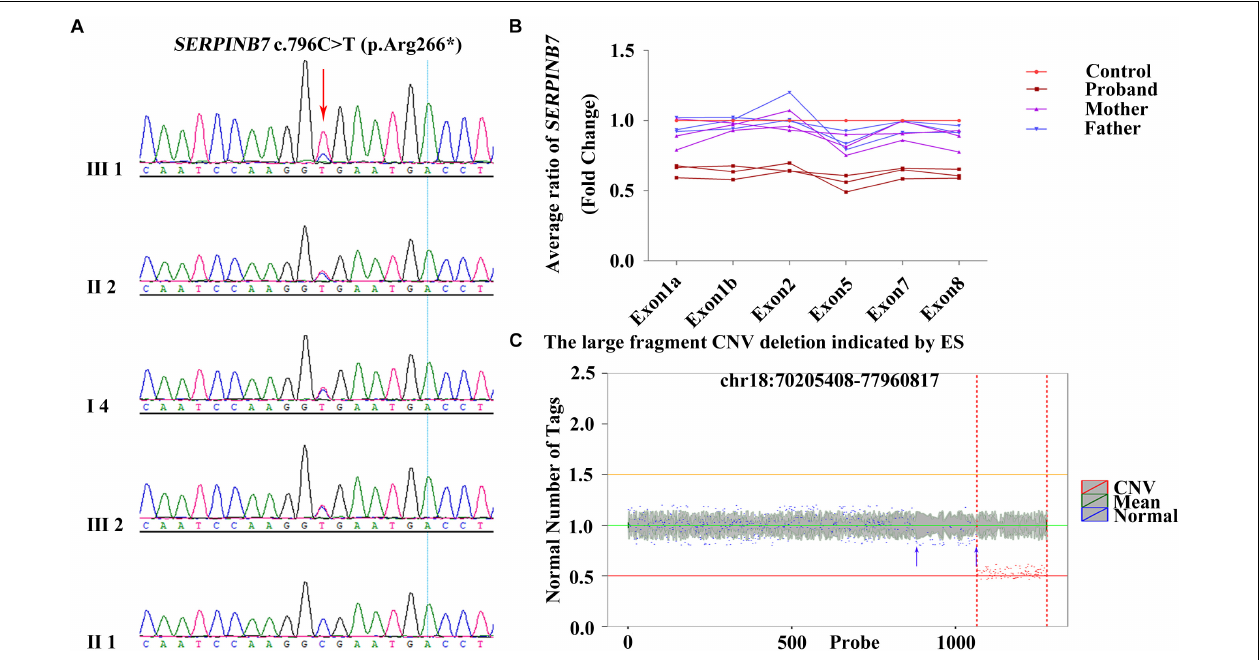
FIGURE 2 | c.796C > T (p.Arg266*) heterozygous variant and exon deletion of SERPINB7 along with and 18q deletion identified by trio-ES. (A) Results of Sanger sequencing confirmed that the heterozygous variant c.796C > T (p.Arg266*) in the proband was inherited from the mother. (B) qRT-PCR results demonstrated that exons 1–8 deletion in the proband was a de novo deletion. (C) Large fragment chromosome CNV deletion indicated by trio-ES in the proband. X -axis: the position on the chromosome corresponding to the region of variation currently displayed. The red and blue marks indicate the areas of variant and normal, respectively. Y -axis: ratio of target sample RPKM value to the mean value of background library RPKM.